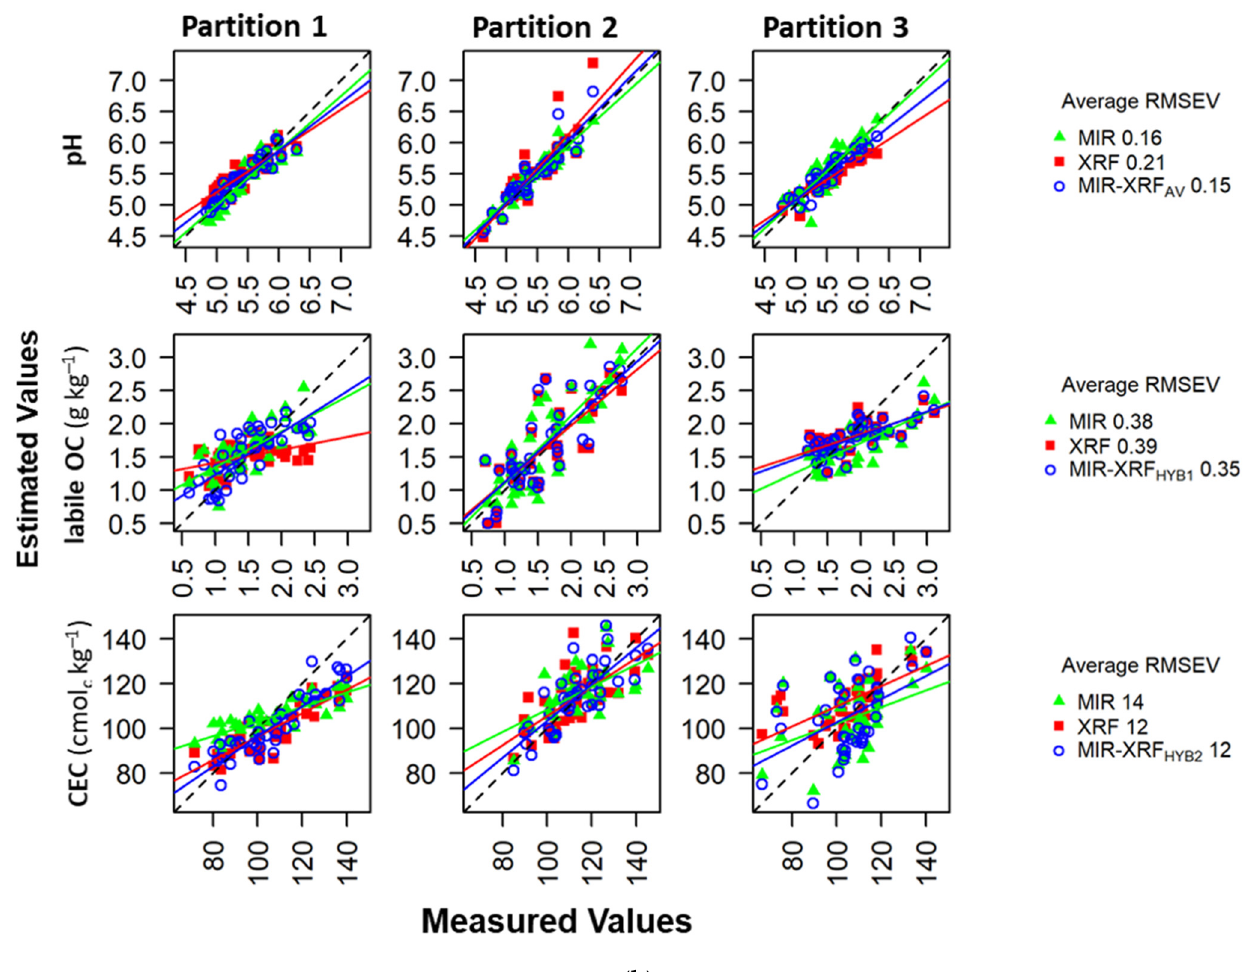
Figure 3. Measured values vs. validation estimates for ( a ) total OC, total N, clay, silt and sand content and ( b ) pH, labile OC content, and CEC using single spectrometers and the best fusion approach according to average RPIQV. Data include validation estimates for all three partitions of the dataset, average RMSEV across the partitions, and weights of the spectrometers in MIR-XRF GR approach where applicable. Regression lines are fit to the data to observe bias. See Table 1 for definitions of model variants.